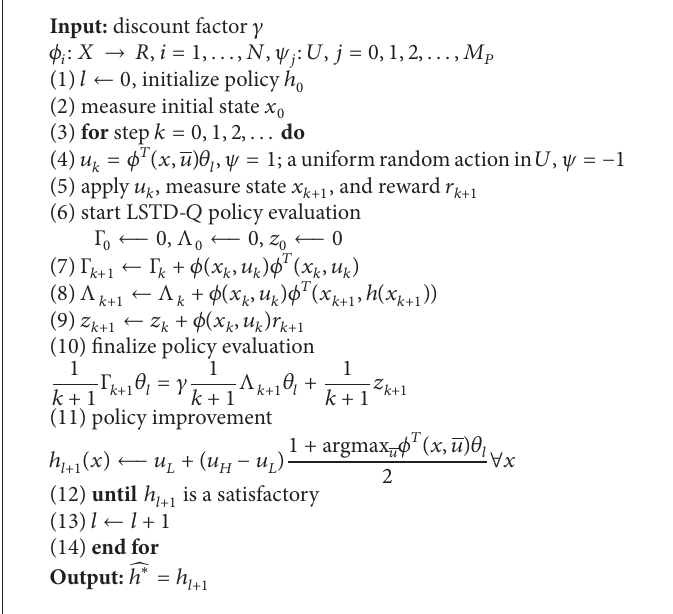
Algorithm 1: Offline Least-Squares Continuous Actions Policy